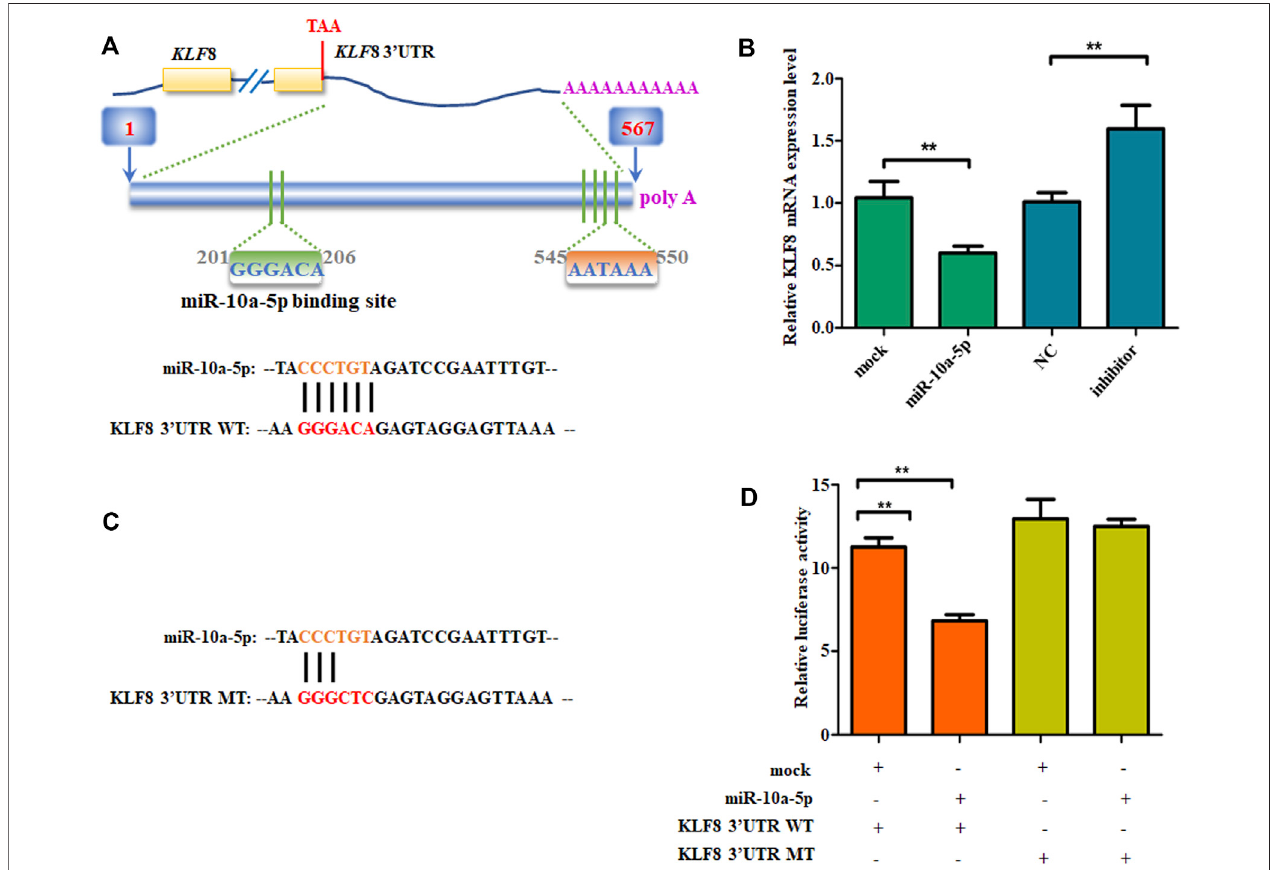
FIGURE 4 | miR-10a-5p directly bind to KLF8 3 ’ UTR. (A) The predicted miR-10a-5p binding site in KLF8 3 ’ UTR. (B) qRT-PCR analysis of levels of genes expression in GIPCs with miR-10a-5p mimics, inhibitor, or each control. (C) mutant miR-10a-5p binding site in KLF8 3 ’ UTR. (D) Luciferase assay of transfected with wild-type or mutant KLF8 3 ’ UTR plasmid in 293T cells. N > or (cid:1) 3 for B and D, * indicates p values < 0.05 and ≥ 0.01, ** indicates p values <